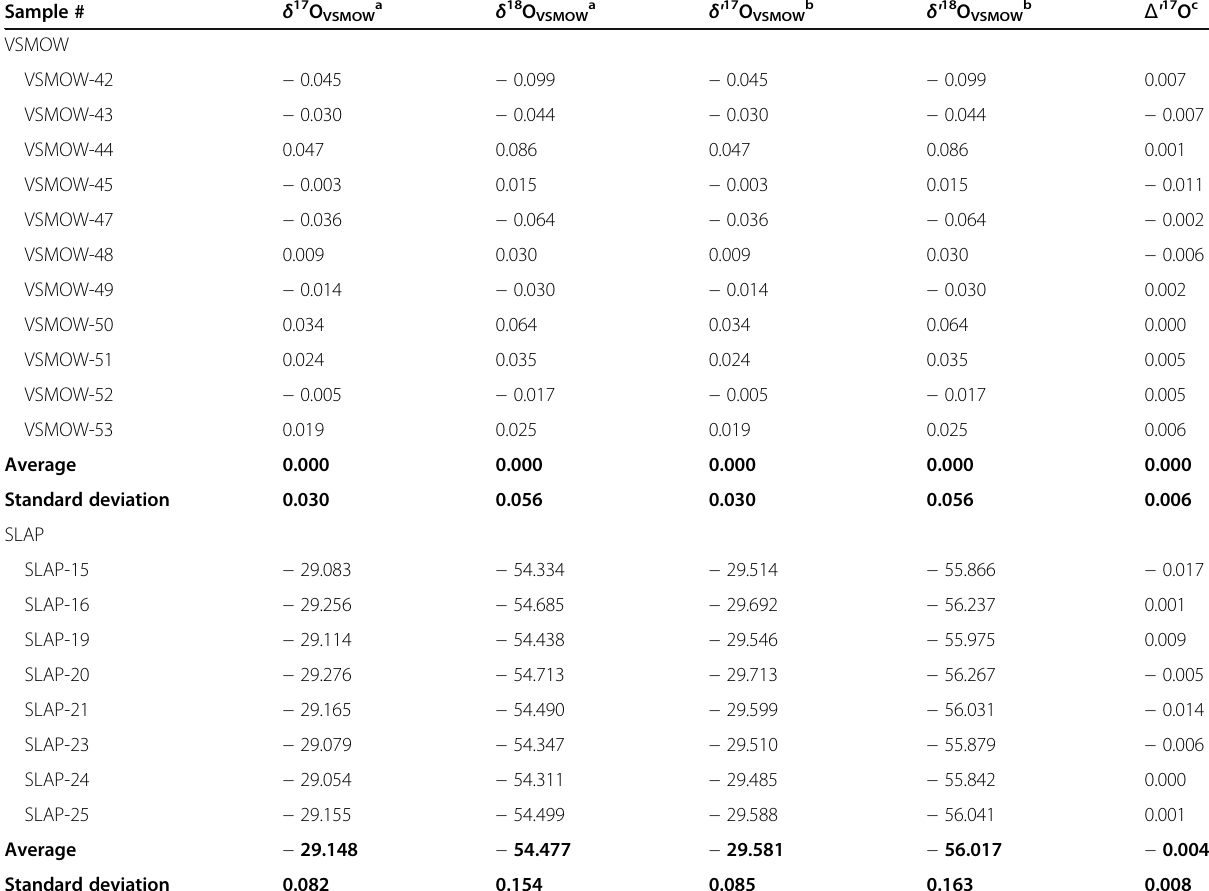
Table 1 Individual standard water data of this study Sample